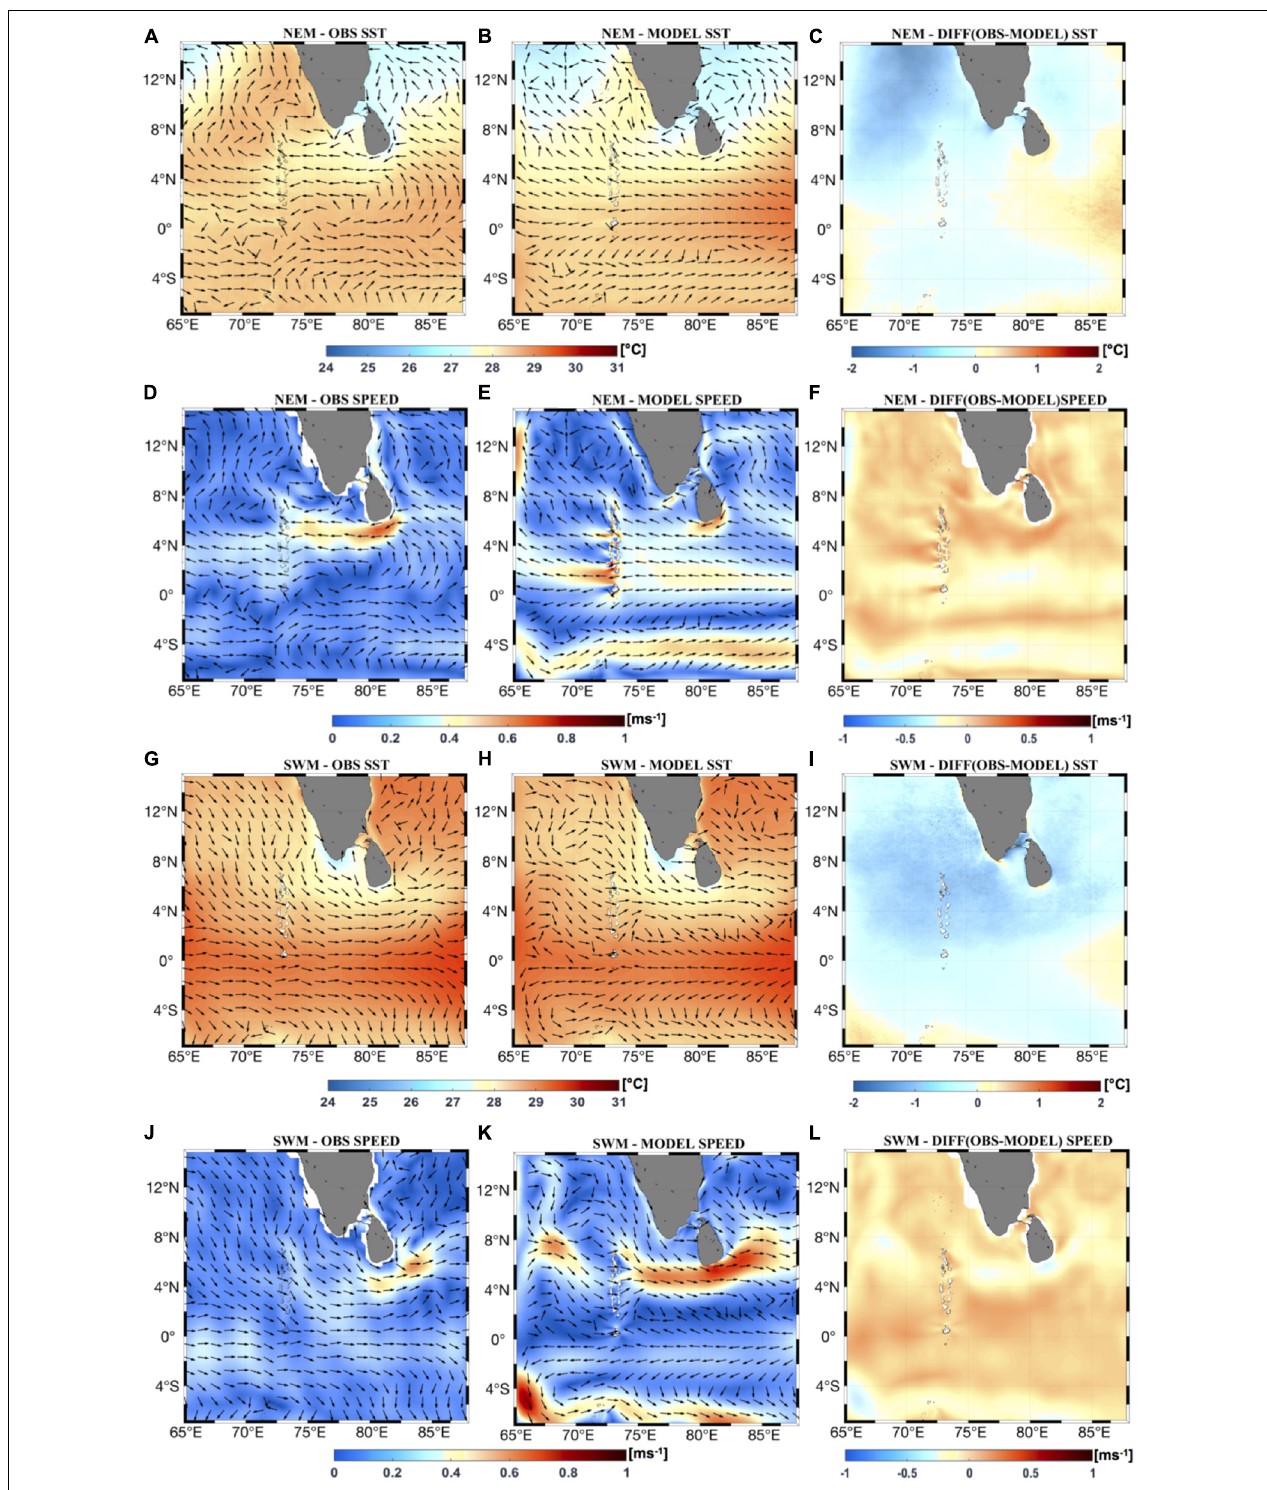
FIGURE 5 | Seasonal climatology of SST and current speeds of observations and model simulations during the NEM (A–F) and SWM (G–L) averaged over 2006–2016. Observational SST was obtained from MODIS-AQUA and mapped with current velocities from OSCAR (arrows) (A,G) . SNIO model SST from were mapped with model current velocities (B,H) . The difference between the observations and model SST were also calculated (C,I) . Observational current speeds were calculated from OSCAR and mapped with current velocities (arrows) (D,J) . SNIO model current speeds from were mapped with model current velocities (E,K) . The difference between the observations and model current speeds were also mapped (F,L)